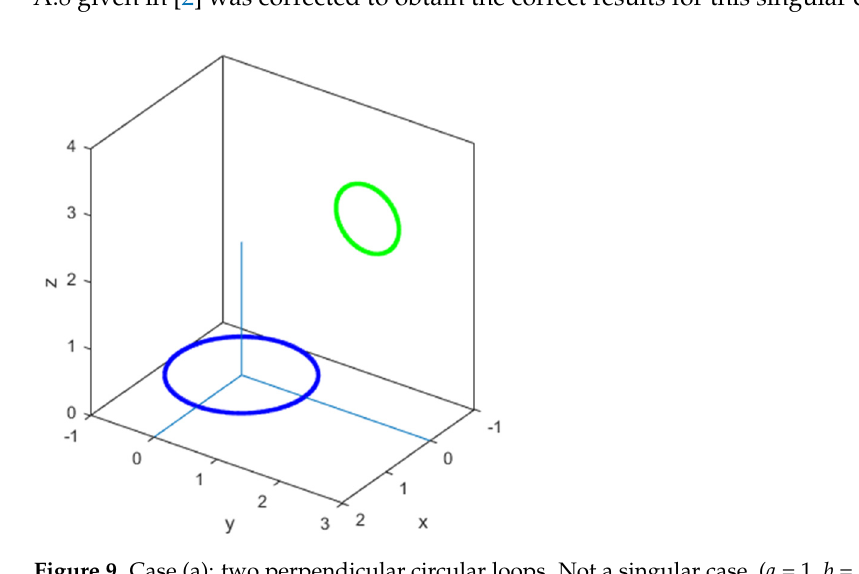
Figure 10. Case (b): two perpendicular circular loops. Not a singular case, ( a = 1, b = c = 0, L = l = 1). Figure 11. Case (c): two perpendicular circular loops. Not a singular case, ( a = 1, b = c = 0, L = l = 1).